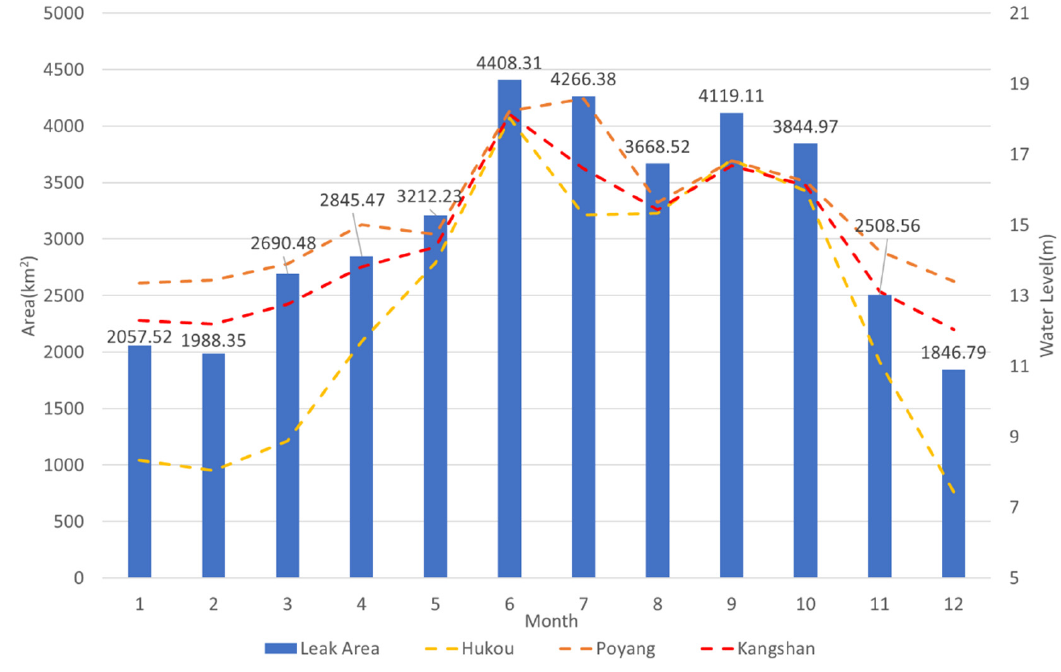
Figure 16. The water area and level of Poyang Lake in 2021.